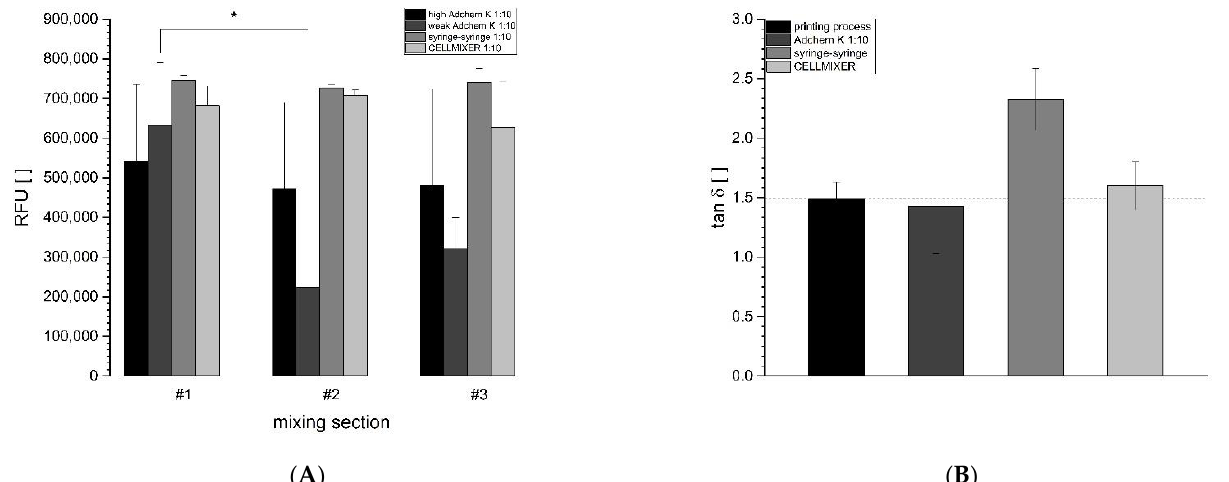
Figure 2. Homogeneity of mixing and rheological properties with a 1:10 mixing ratio at 37 °C in three commercial devices. ( A ) Homogeneity of a fluorescein dye in three time-dependent mixing sections. ( B ) Rheological properties after mixing with respect to an established heating process for bioprinting after 30 min at 37 °C (black column). Data are means ± SD ( n = 3; Kruskal – Wallis test * p < 0.05).